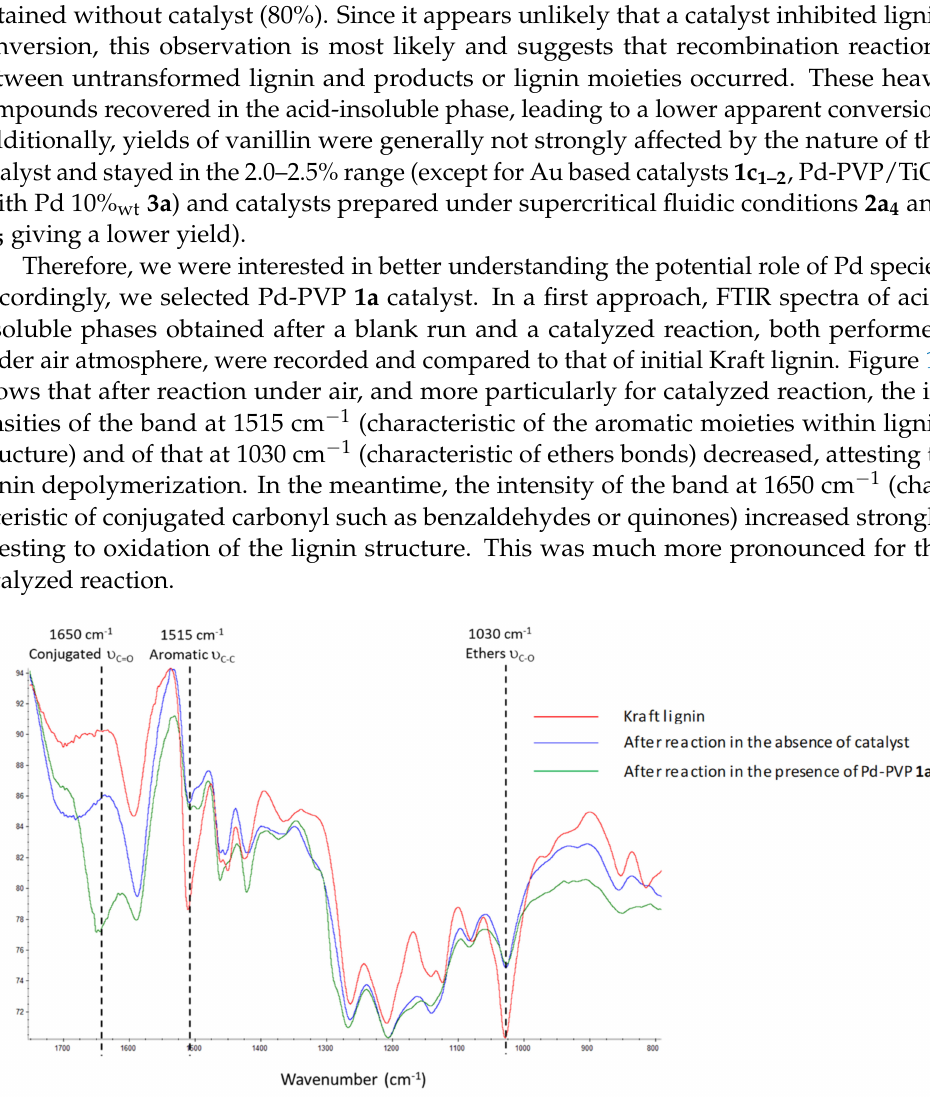
Figure 11. FTIR spectra of initial lignin and acid-insoluble phases after catalyzed and un catalyzed reactions (150 ◦ C, P air 20 bar, 1 h, C lignin 5 g L − 1 , C NaOH 10 g L − 1 , and Pd 10% wt